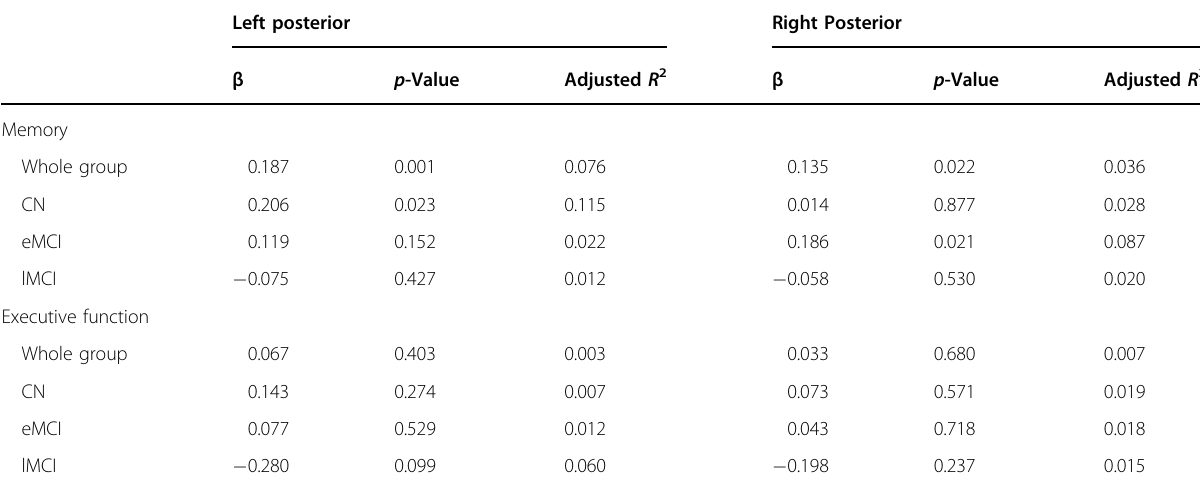
Table 1 Posterior hippocampal redundancy-cognition regressions for averaged density.